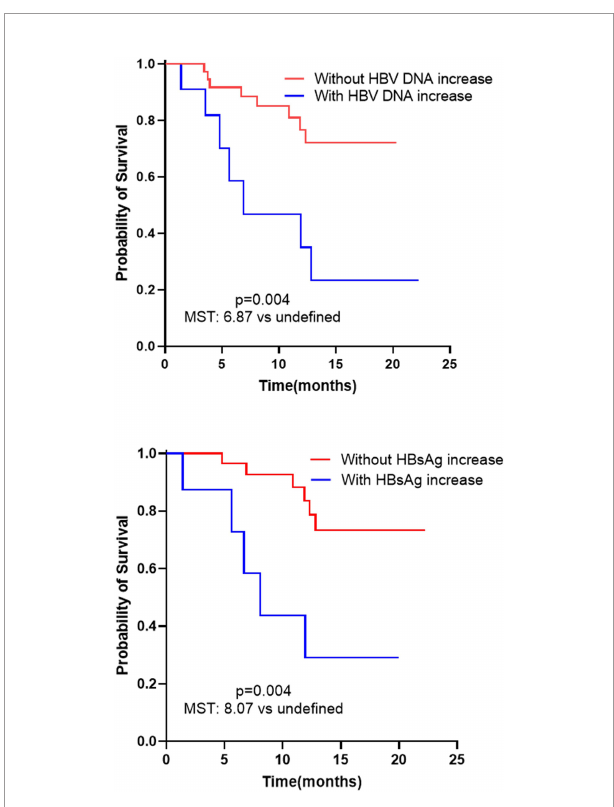
FIGURE 3 | Correlation analysis between tumor response, survival time and the elevation of HBV DNA and HBsAg levels. Kaplan – Meier overall survival estimate curves in patients with increasing HBV DNA and HBsAg and patients exhibiting no increase in HBV DNA and HBsAg. HBsAg, hepatitis B surface antigen; HBV, hepatitis B viral; MST, median survival time.